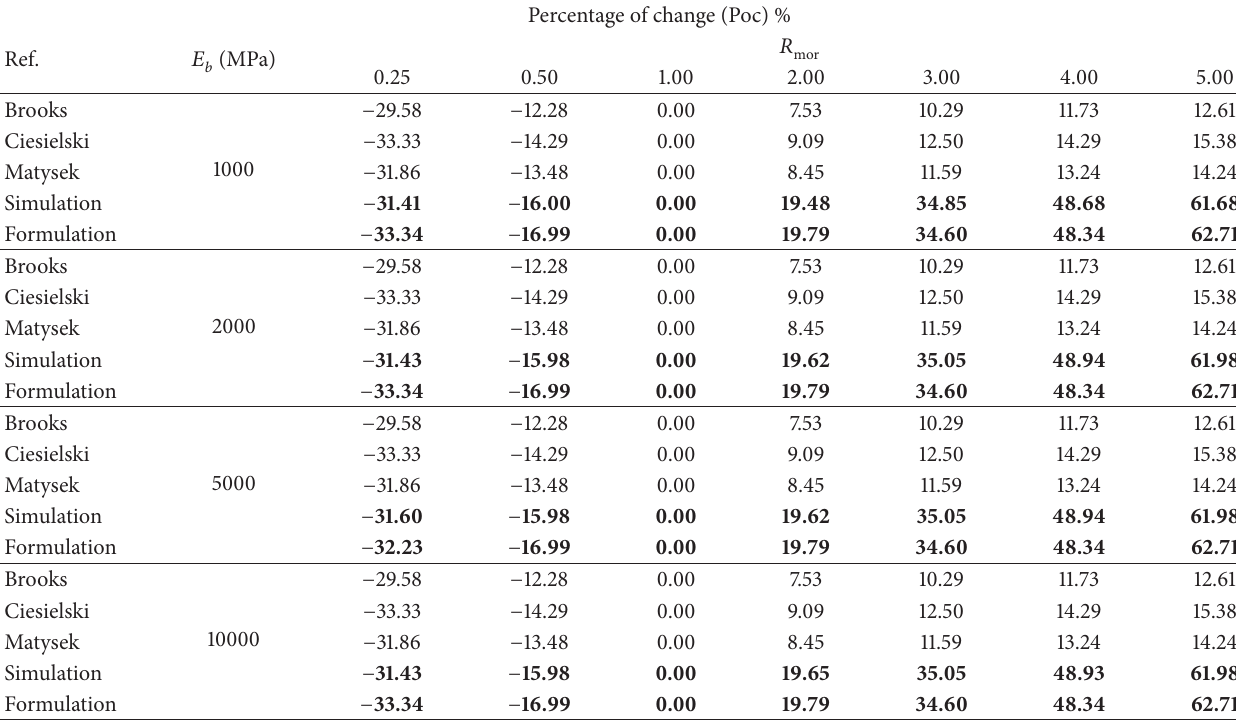
Table 6: Percentage of change of formula comparison.